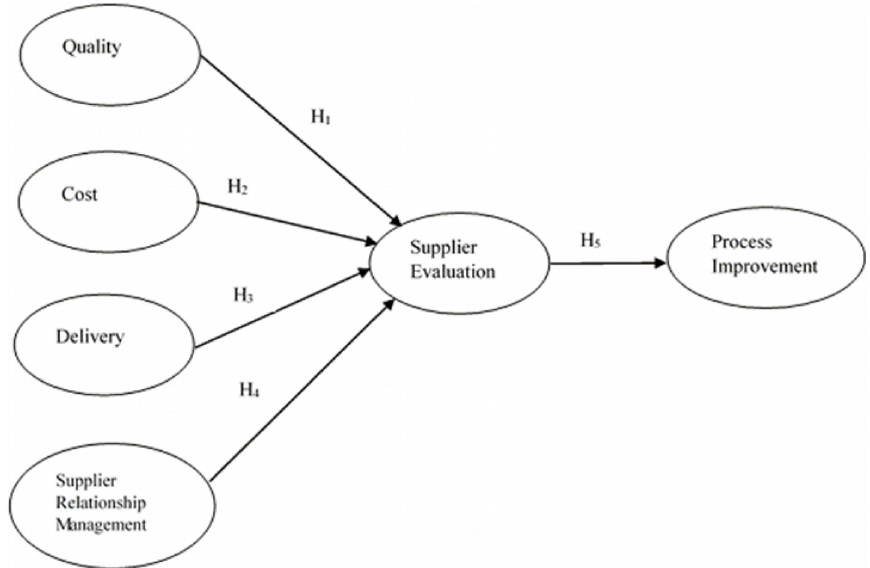
Figure 1. Hypothetical research